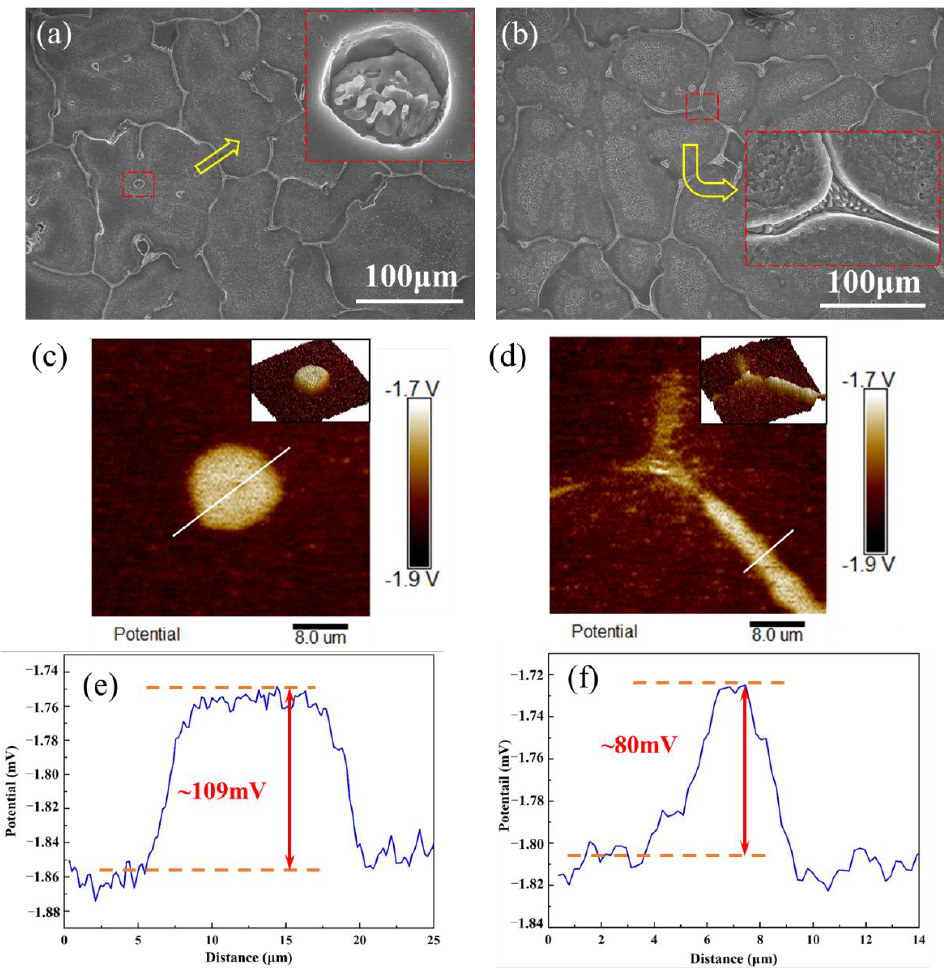
Figure 4. SEM images and SKPFM analysis of the ZM-0.3Ca alloy: ( a ) SEM images of the spherical secondary phase and ( b ) the dendritic secondary phase; ( c ) SKPFM maps of the spherical secondary phase and ( d ) the dendritic secondary phase; ( e ) the Volta potential profile of line as indicated in ( c ); ( f ) the Volta potential profile of line as indicated in ( d ).